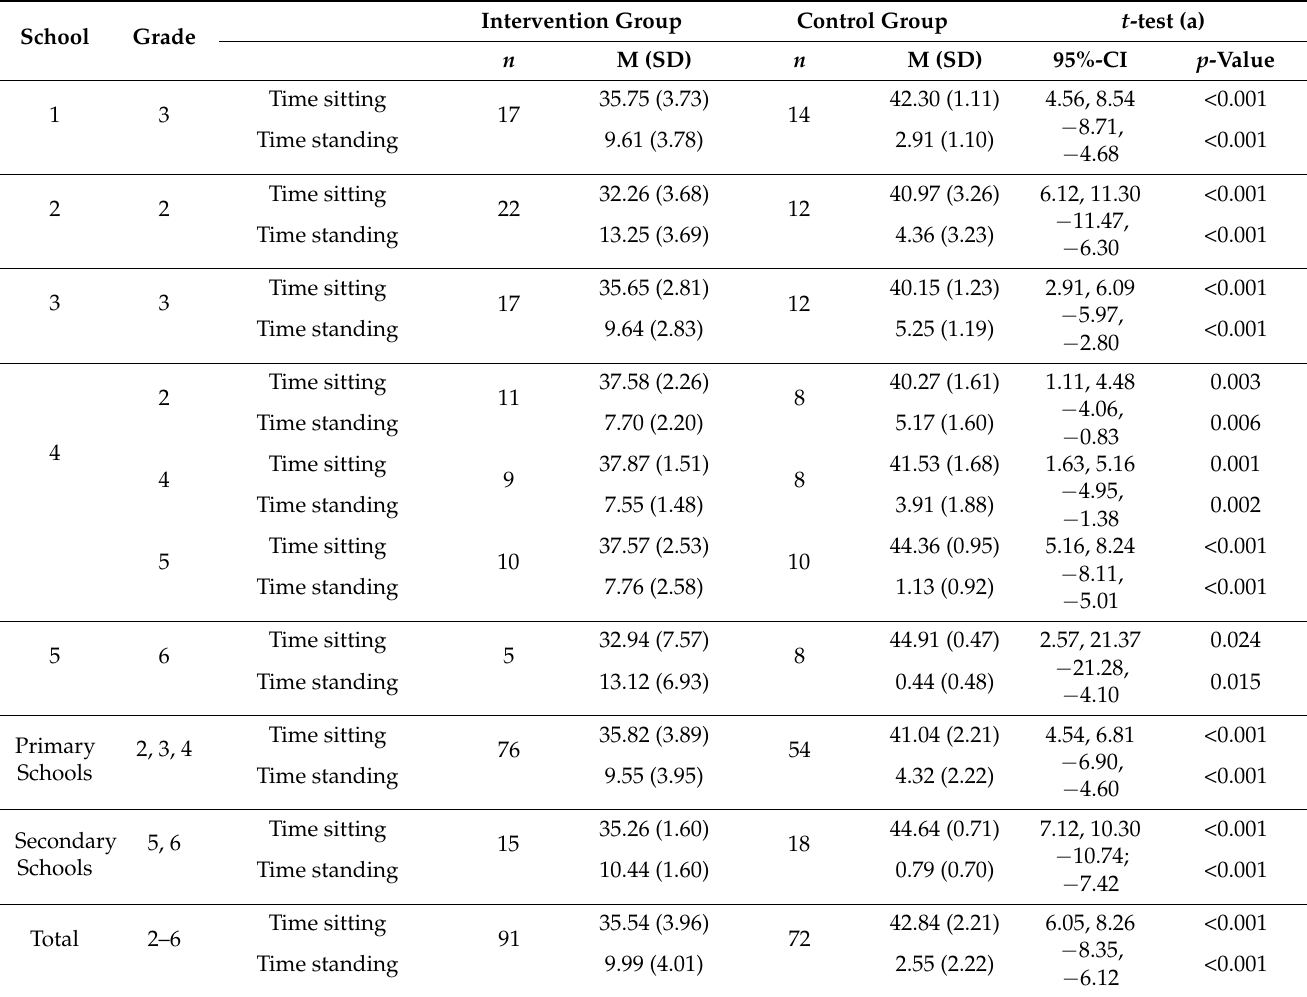
Table 3. Average sitting and standing time per 45 min school hour clustered in intervention and control group stratified for schools and primary and secondary school